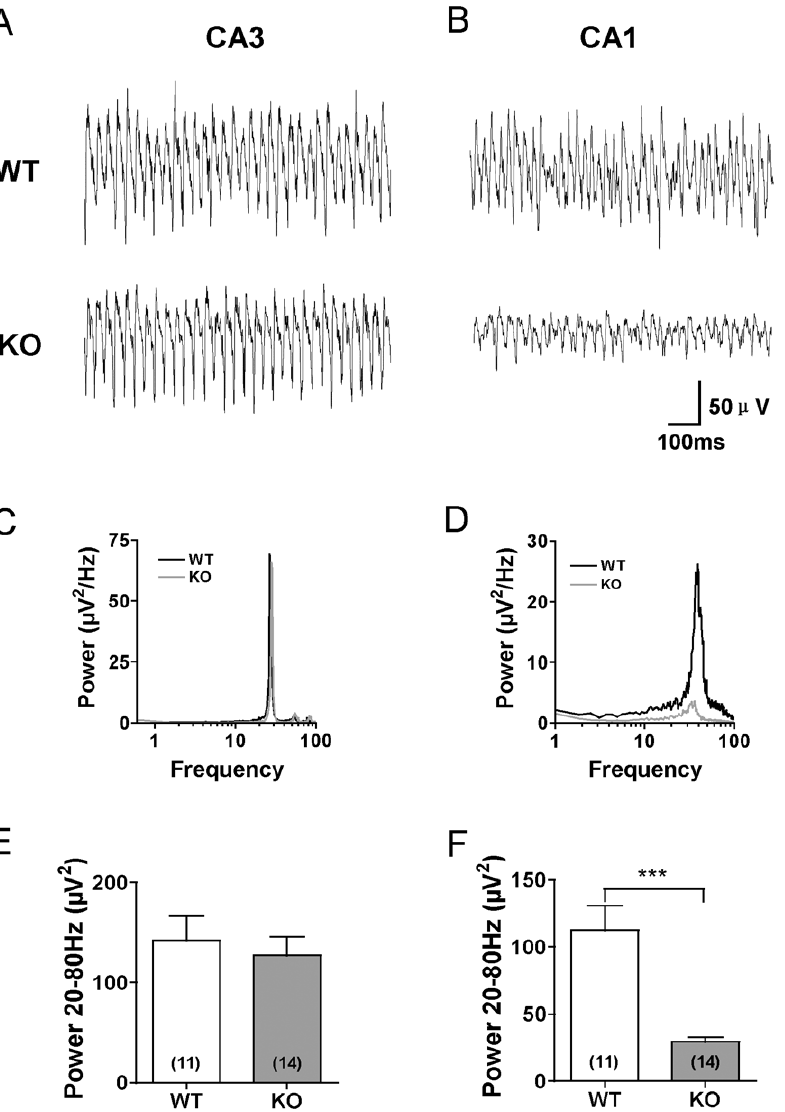
Figure 1. Power of gamma oscillations is reduced in area CA1 but not CA3 in slices from KO mice. A–B. Example traces of field oscillations induced by 25 m M carbachol in hippocampal areas CA3 (A) and CA1 (B). C–D. Power spectra for oscillations in A (C) and B (D). E–F. Pooled data for integral oscillation power (20–80 Hz) in area CA3 (E) and CA1 (F). ***p , 0.001. Data represent mean 6 SEM.